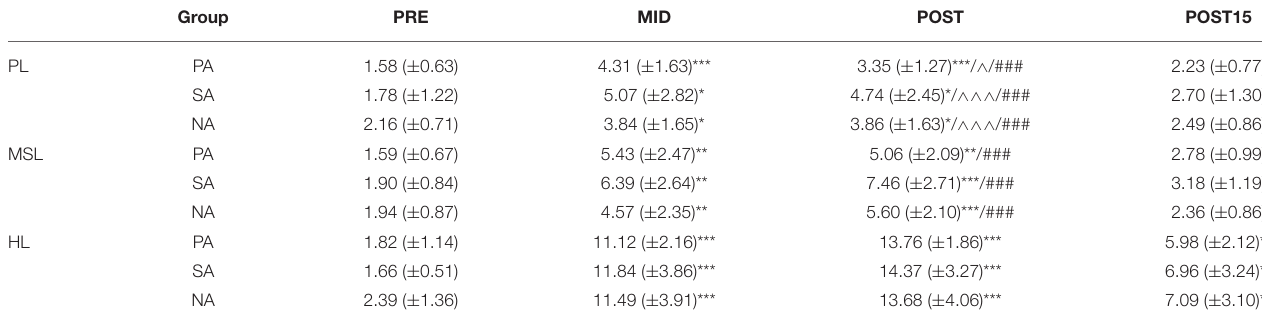
TABLE 2 | Blood lactate concentrations (mmol/l) (group mean ± SD) during three resistance exercise loadings in power (PA), strength (SA), and non-athletes